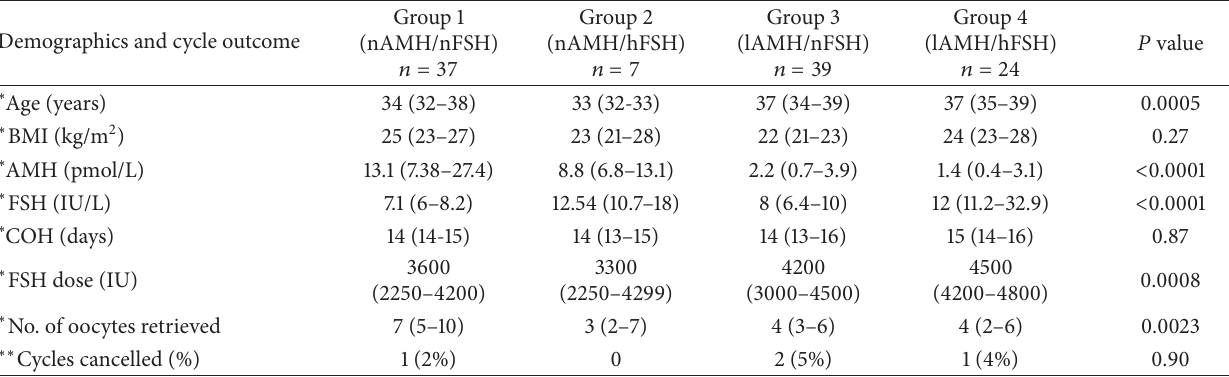
Table 1: Comparison of the demographics and cycle outcome.